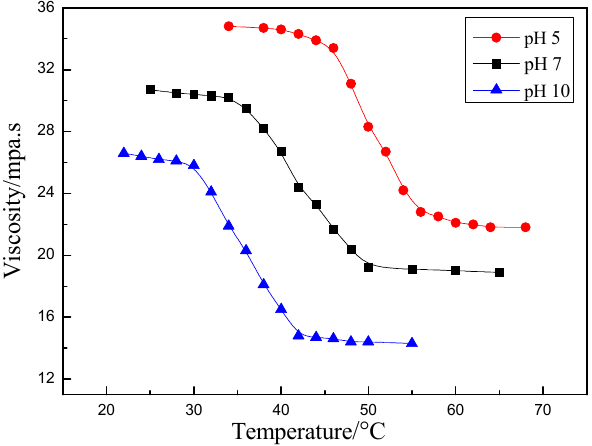
Figure 3. Viscosity curves of 1 wt % P2 in aqueous solution versus temperature at different pH values.